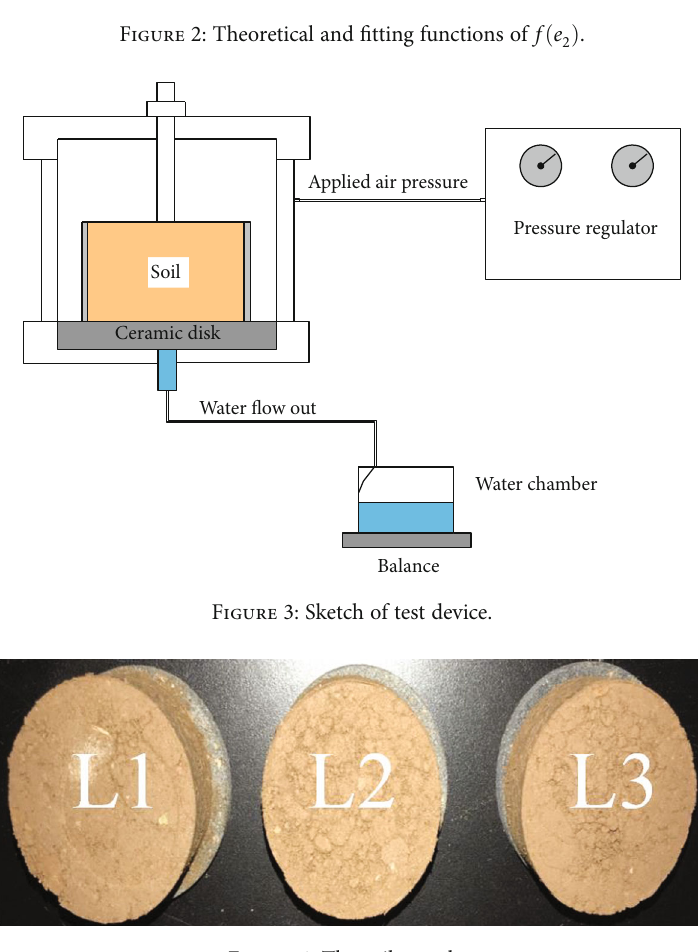
Figure 4: The soil samples.